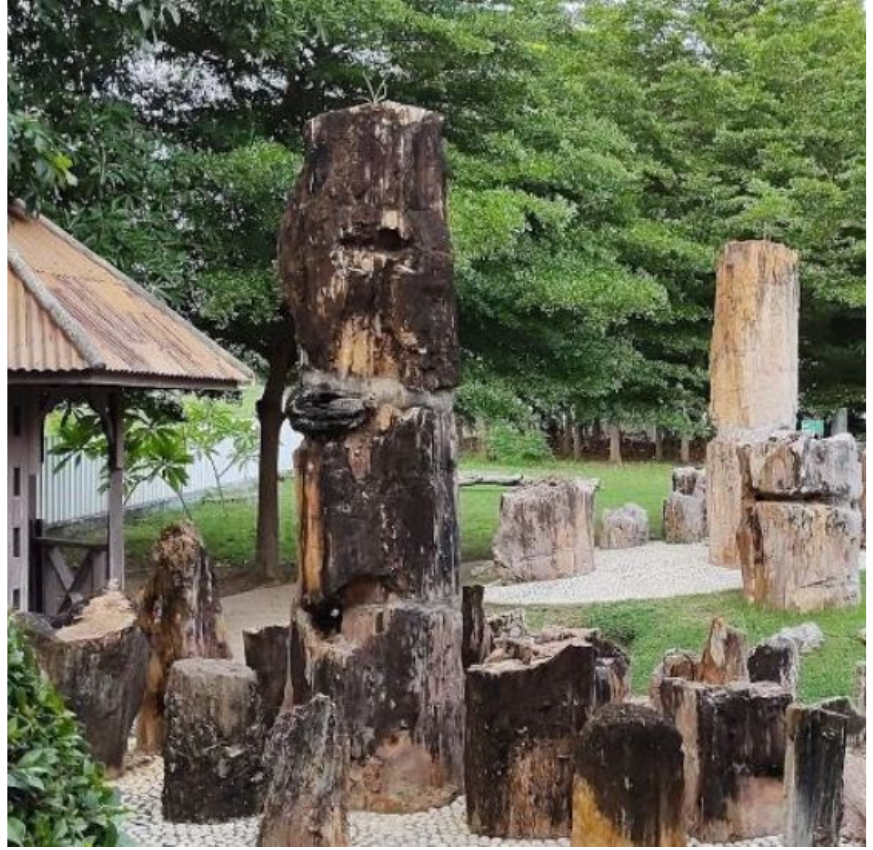
Figure 27. Fossil logs at Khorat petrified wood museum show dark discolorations from microbes.